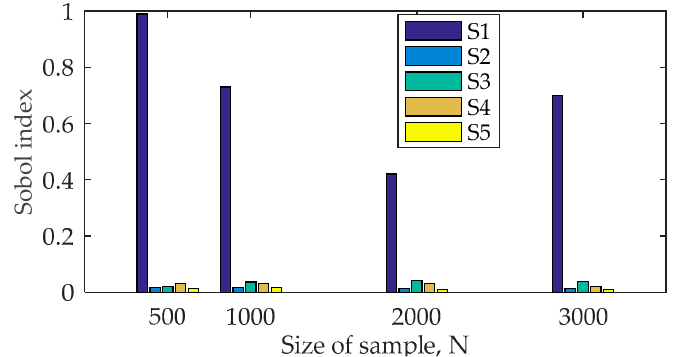
Figure 9. Sobol indices 𝑆𝑖 versus sample size 𝑁 .